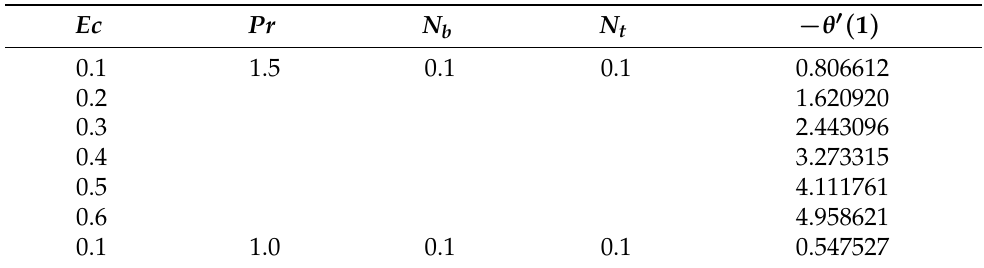
Table 6. Numerical outputs of − θ (cid:48) ( 1 ) for Ec , Pr , N b and N t when De = γ = 0.01, Ha = δ = 0.1, S = Da = 1 and λ 1 = Le = R =